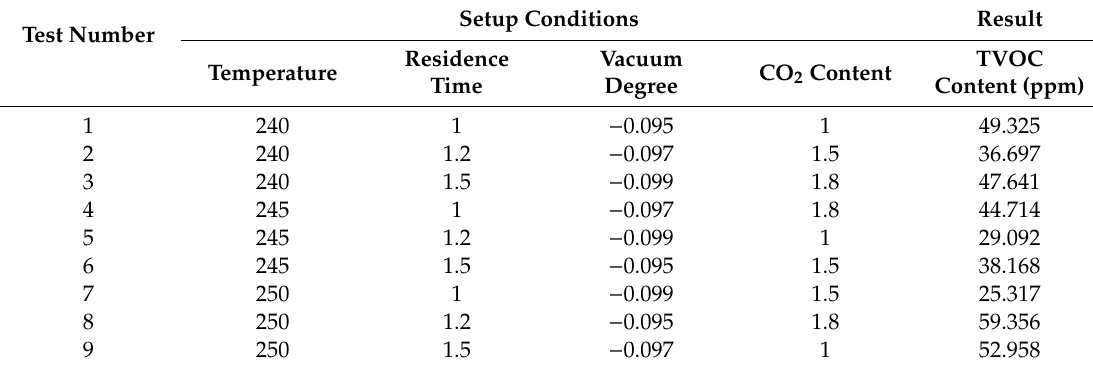
Table 3. Orthogonal experimental design and